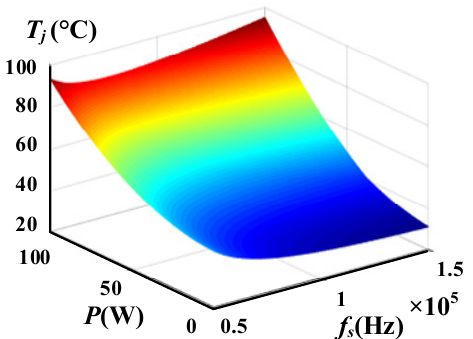
Figure 5. Operating junction temperature of power device.